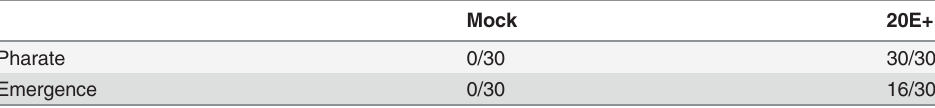
Table 4. Effects of 20E injection of nymphs after dsSpo